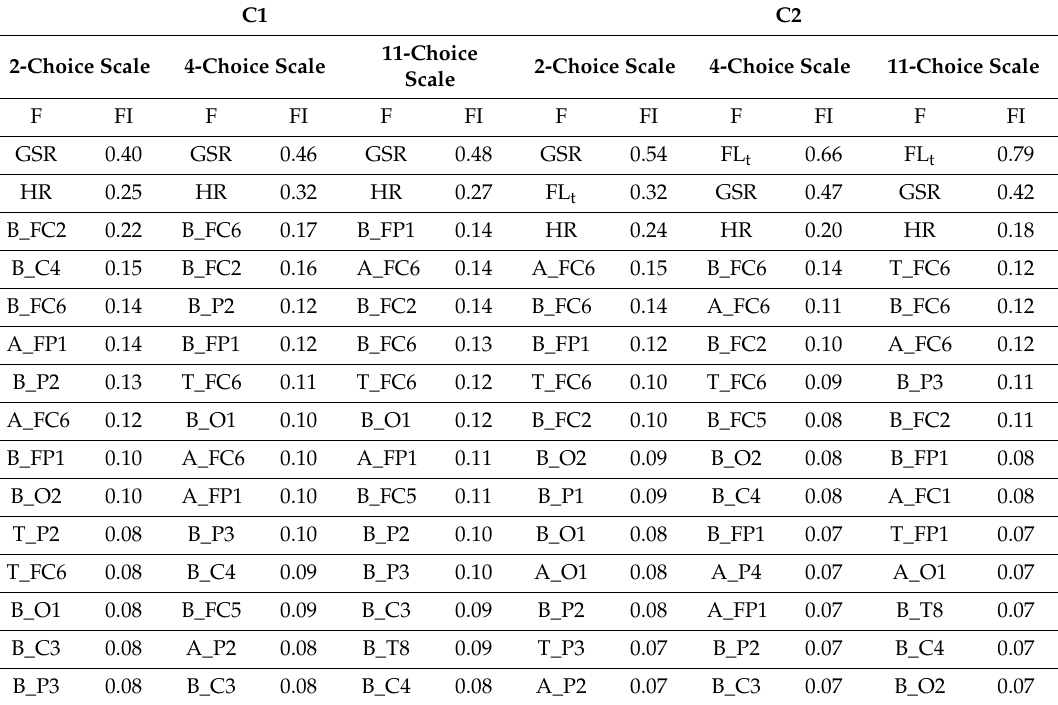
Table 9. Feature (F) and feature importance (FI) for the player-dependent